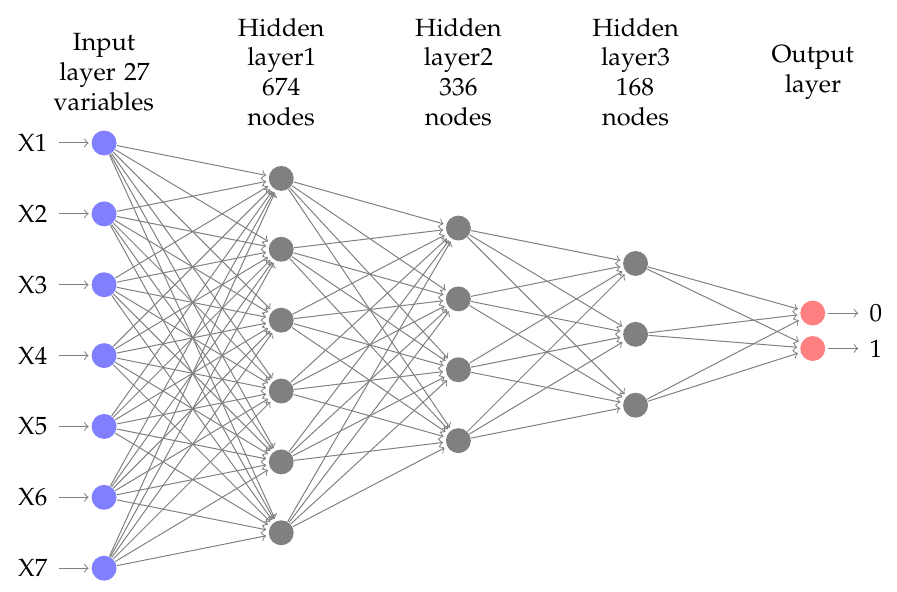
Figure 3. Multilayer Perceptron Architecture.